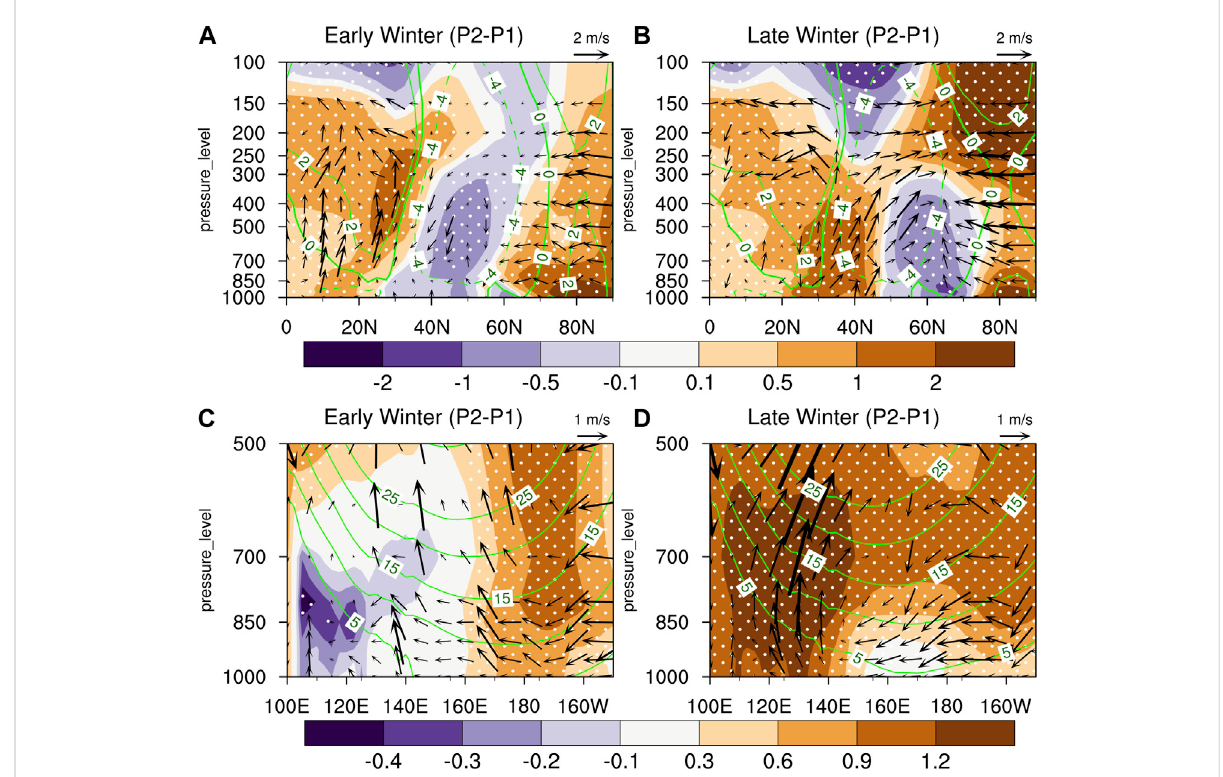
FIGURE 8 Verticalpro fi lesofthedifferences intemperature (shading;units: K)and circulation fi eld (arrows;units: m/s)between P1andP2 inearlyand late winters. (A,B) Latitude – height vertical cross-section for East Asia (115 – 120 ° E average), the solid green lines represent the multi-year average of meridional winds during the P1 and P2. (C,D) Longitude – height vertical cross-section for East Asia (30 – 37.5 ° N average), the solid green lines represent the multi-year average of latitudinal winds during the P1 and P2. The white slanted dots represent p <